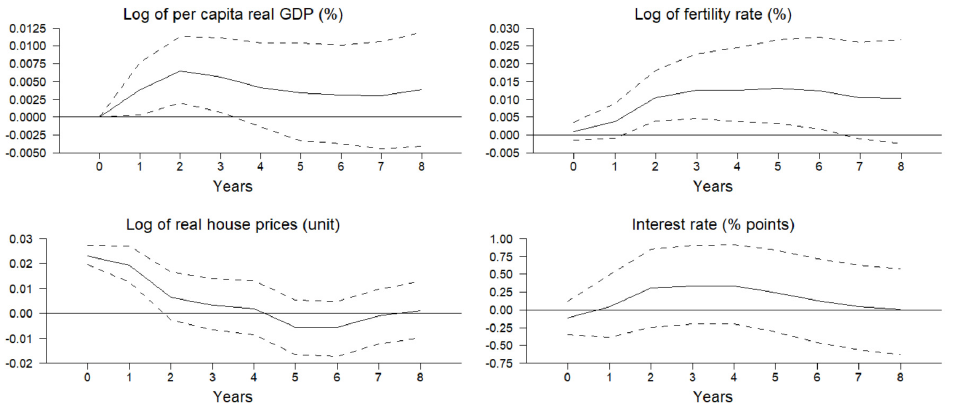
Figure 8. Responses to a house price shock in the baseline structural VAR with the homeownership rate as an exogenous variable in the model.